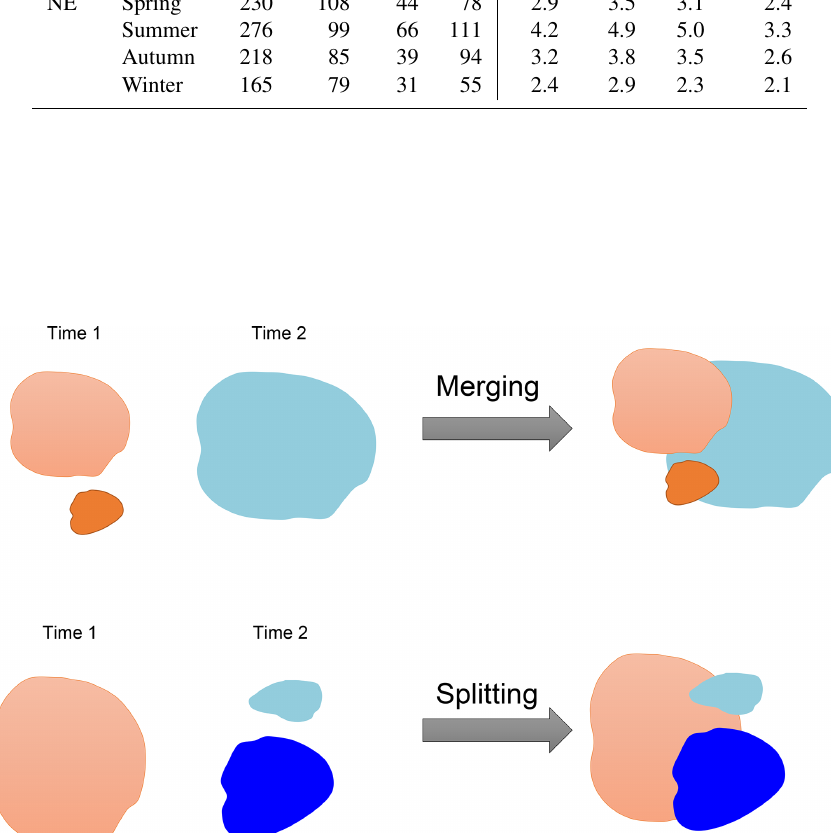
https://doi.org/10.5194/essd-13-827-2021 Earth Syst. Sci. Data, 13, 827–856,